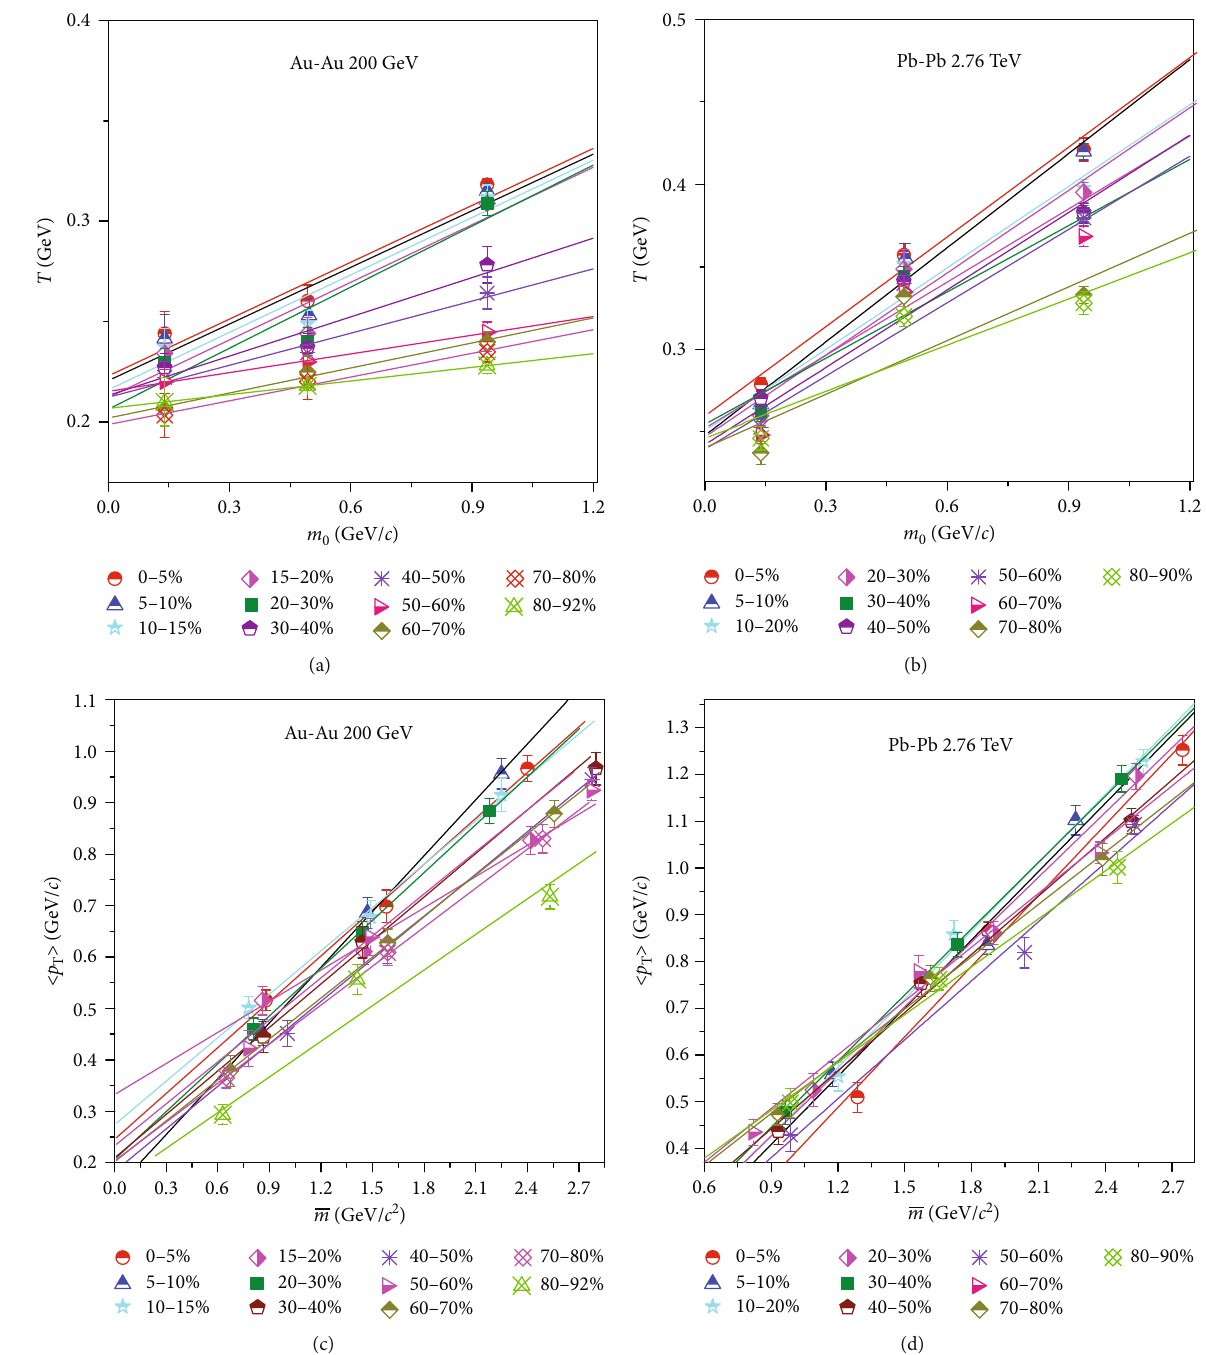
h p i on the mean energy 0 and (c, d) mean transverse momentum T